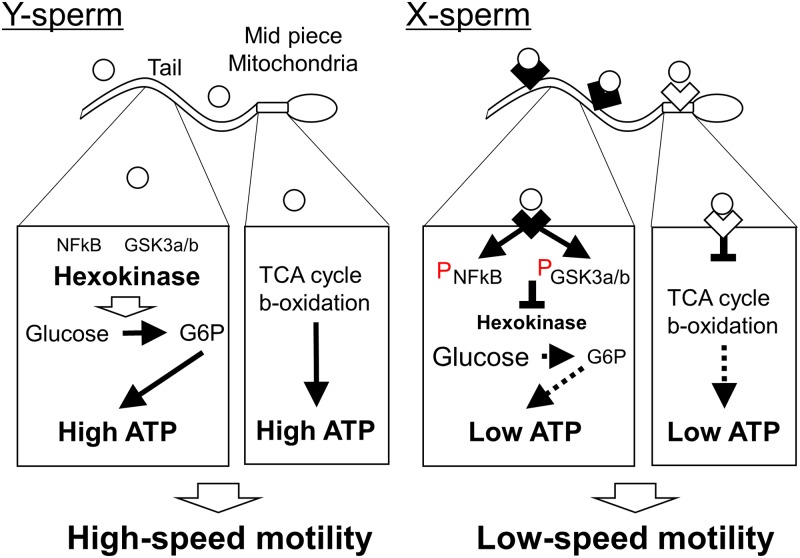
The model of ATP production in Y-sperm and X-sperm under TLR7/8-ligand condition.In Y-sperm, mitochondrial and glycolytic ATP production occur regardless of the presence of TLR7/8 ligand (). Thus, Y-sperm showed high-speed motility. On the other hand, in X-sperm, the activation of TLR8 localized in the midpiece () suppressed mitochondrial ATP production. Additionally, the activation of TLR7 localized in the sperm tail () phosphorylated NFκB and GSK3α/β and then suppressed the activity of hexokinase. As a result, ATP production in X-sperm was decreased under TLR7/8-ligand condition. Thus, only X-sperm showed low-speed motility under TLR7/8-ligand condition. GSK3α/β, glycogen synthase kinase 3α/β; TLR7/8, Toll-like receptor 7/Toll-like receptor 8; NFκB, nuclear factor-kappa B; X-sperm, X chromosome–bearing sperm; Y-sperm, Y chromosome–bearing sperm.